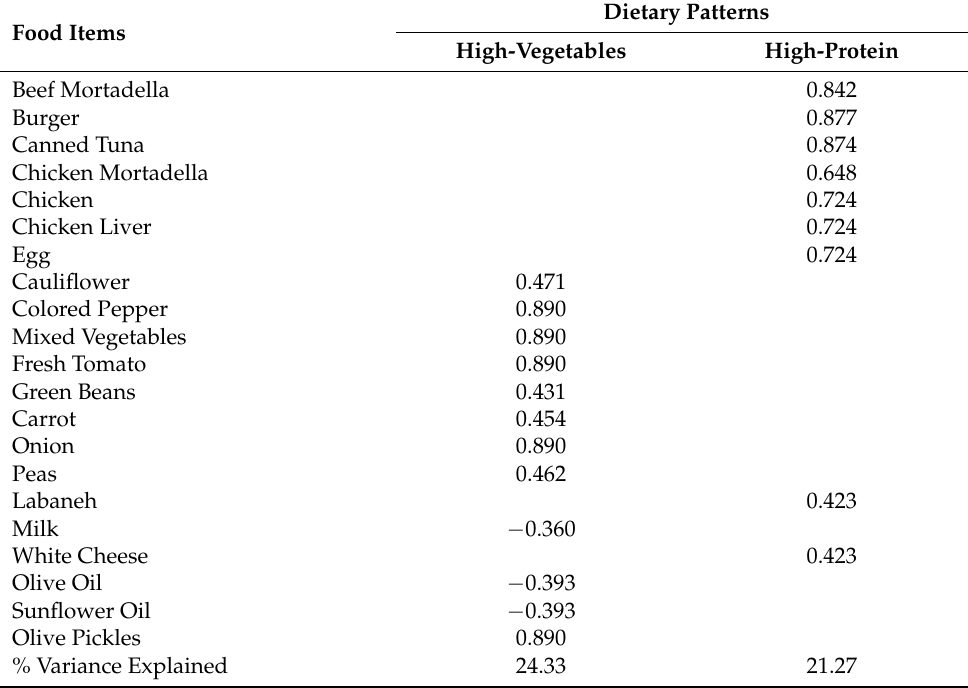
Table 1. Factor loadings for the two rotated factors in IBD ( n = 185) and controls ( n =